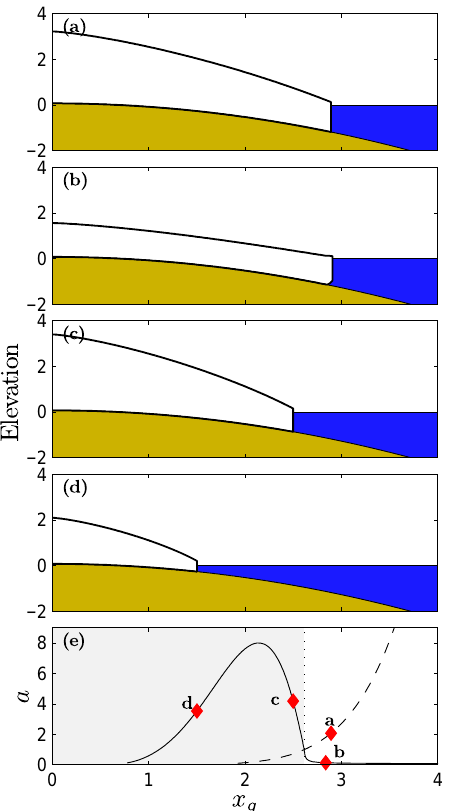
Figure 3. Steady-state profiles, with w ≡ 1, n = 1 /m = 3, r = 0 . 9, γ = 0, ε = 0 . 01, λ = 7 . 0304 rε n 2 /(n + 1 ) 2 , b(x) = ε n 2 /(n + 1 ) ( 1 − 2 x 2 ) . The apparently contrived form in which λ and b are written is designed to make comparison with Sect. 4.2 simpler, whereby the corresponding variables (cid:51) and B are then easy to extract. Panel (e) shows grounding line positions x g against surface accumu- lation rate a for the CD calving model (solid line, grounded where the background is shaded grey) and FL calving law (dashed line). (a–d) Steady-state profiles, same colour scheme as in Fig. 1, same horizontal axis as in (e) . (a) The FL calving law, a = 2 . 08. (b–d) CD calving law with a = 0.134 (b) , 4.18 (c) , 3.54 (d) . Red diamonds in (e) refer to the steady state in the panel indicated by the letter label.